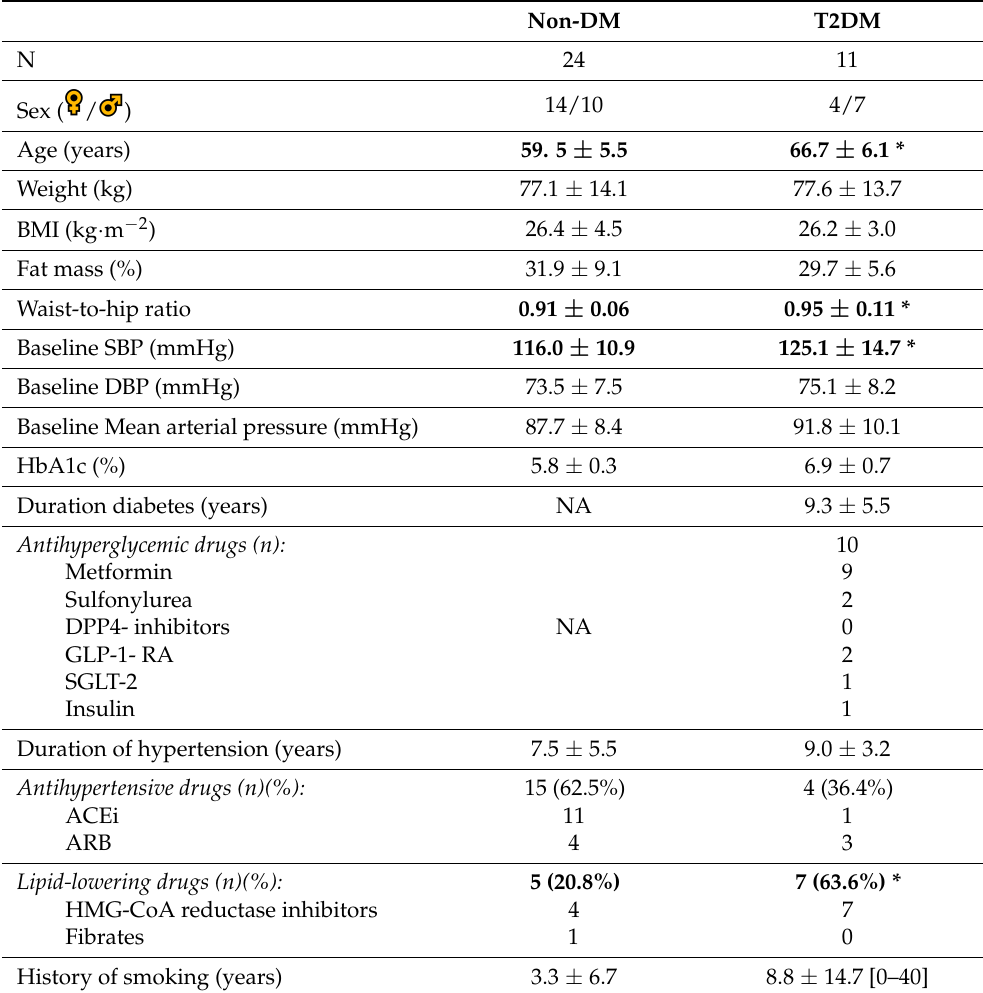
Table 1. Participants’ characteristics.